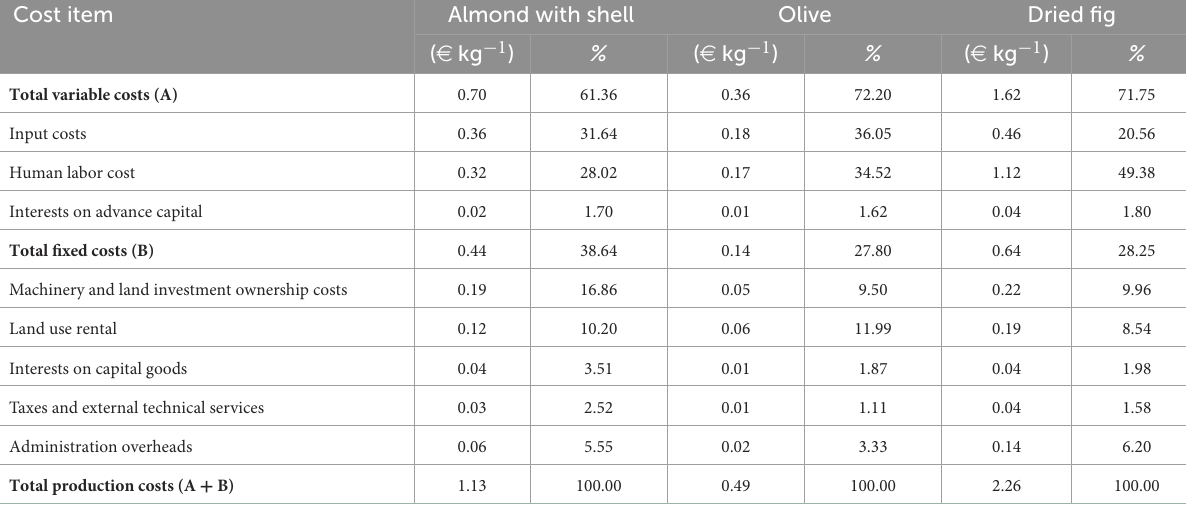
TABLE 6 Operating costs in the constant production stage per